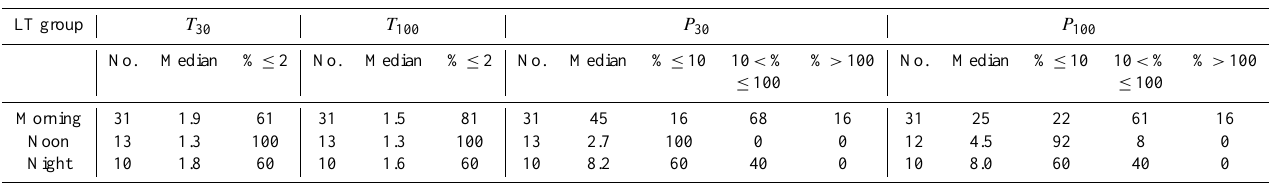
Table 1. Summary of the statistics in Fig. 2, showing the maximum change from point to point during each overpass, divided according to time of day, energy, and whether trapped or precipitated.